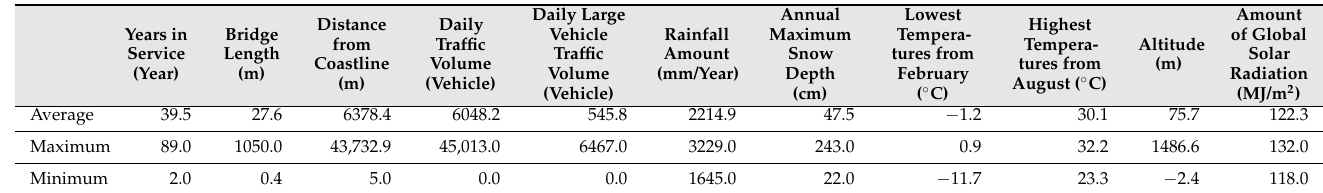
Table 2. Average, maximum, and minimum of each index used in this